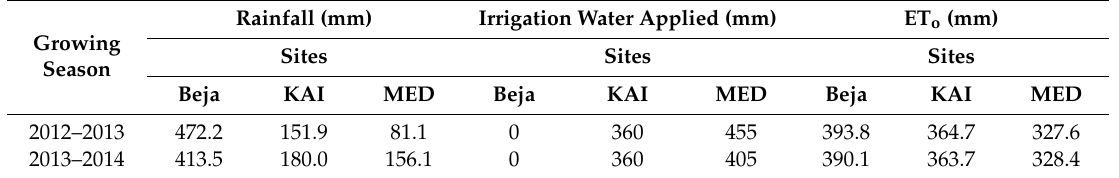
Table 1. Rainfall, irrigation water applied and evapotranspiration (ET o ) in three trial sites. Growing